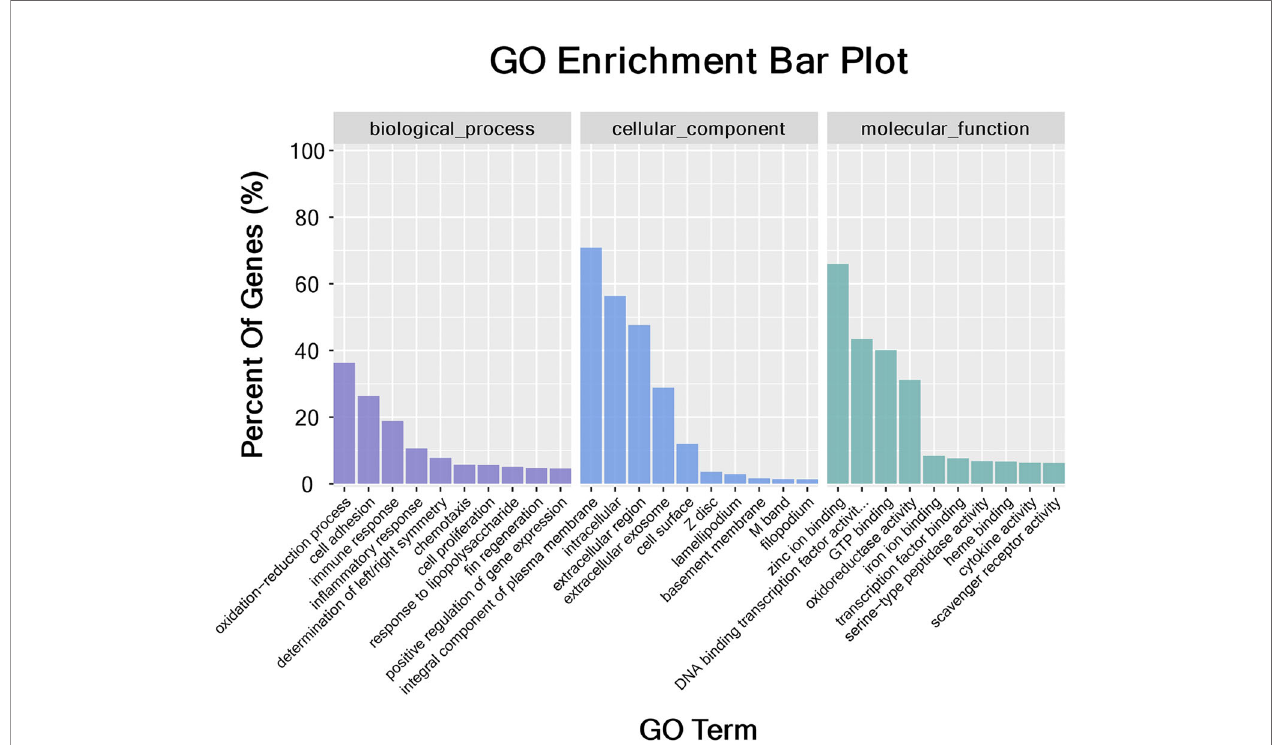
FIGURE 6 | Gene Ontology (GO) categorization of differentially expressed genes in skin. Each annotated sequence was assigned at least one GO term in the following categories: biological process, cellular component, or molecular